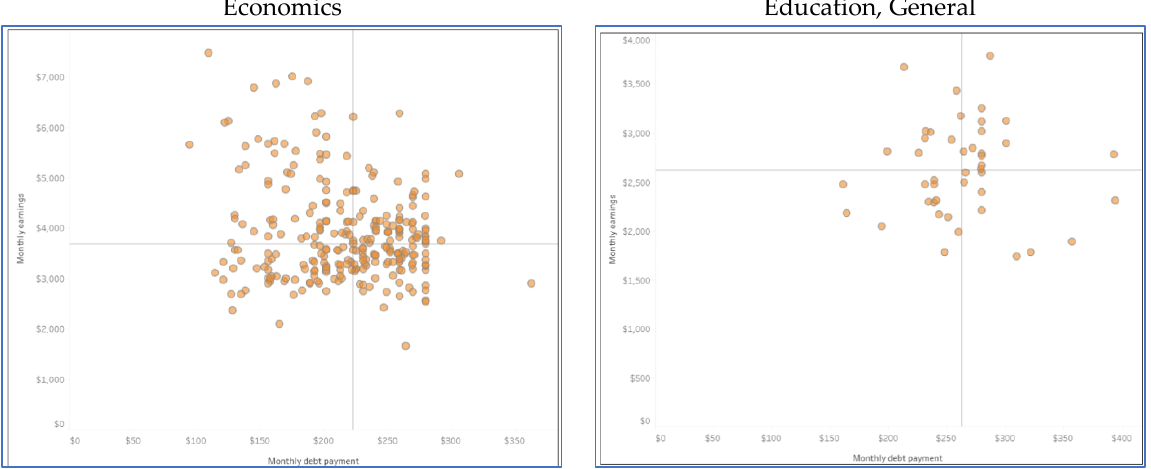
Figure 4. First Year Monthly Expected Earnings and Debt Payments for Bachelor’s Degrees. Source: Buyer Beware Interactive Tool, based on Carnevale et al. (2020a).